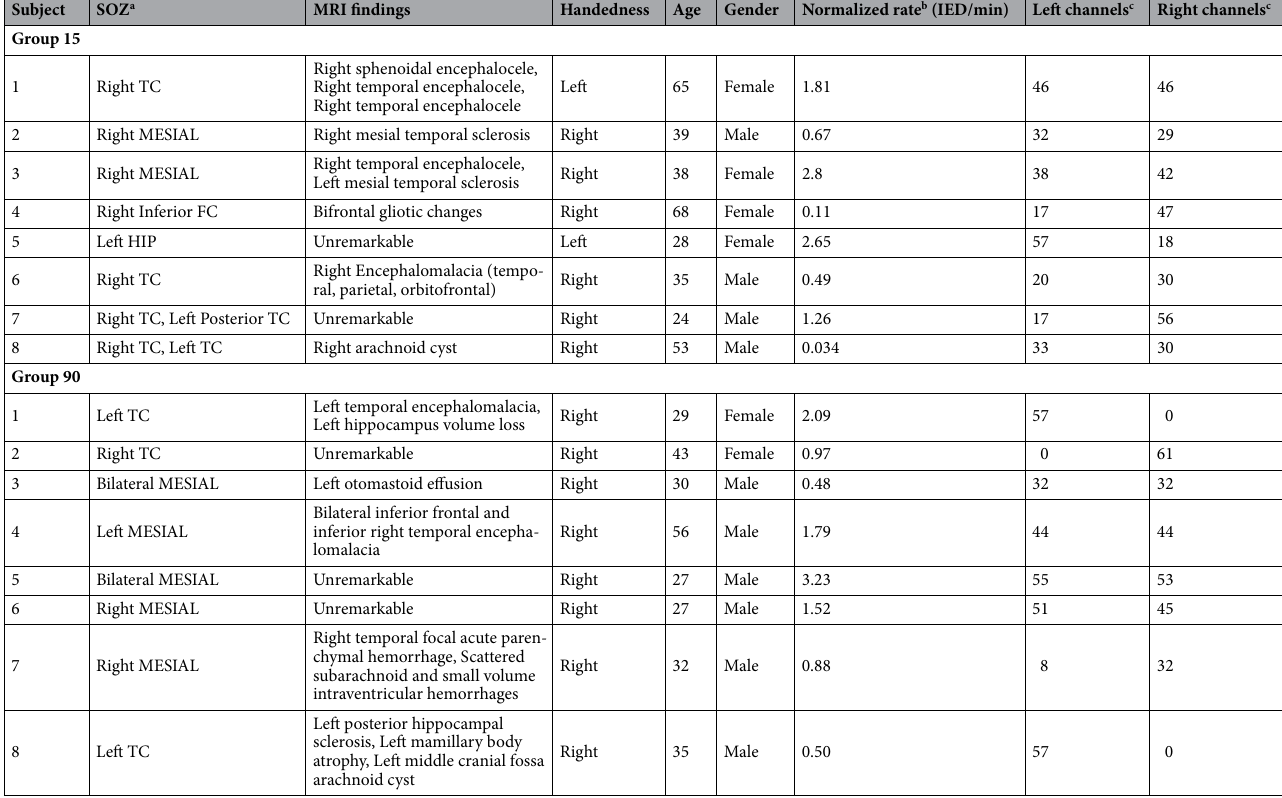
Table 1. Subject information. a Seizure Onset Zone (SOZ) corresponds to areas that initiated clinical seizures during intracranial monitoring. FC Frontal Cortex, TC Lateral Temporal Cortex, MESIAL Mesial Temporal Cortex. b Time-adjusted baseline IED rates averaged over all contacts with at least one IED during the task window. c Denotes the number of contacts remaining after the exclusion of bad channels and channels outside of co-registered grey matter